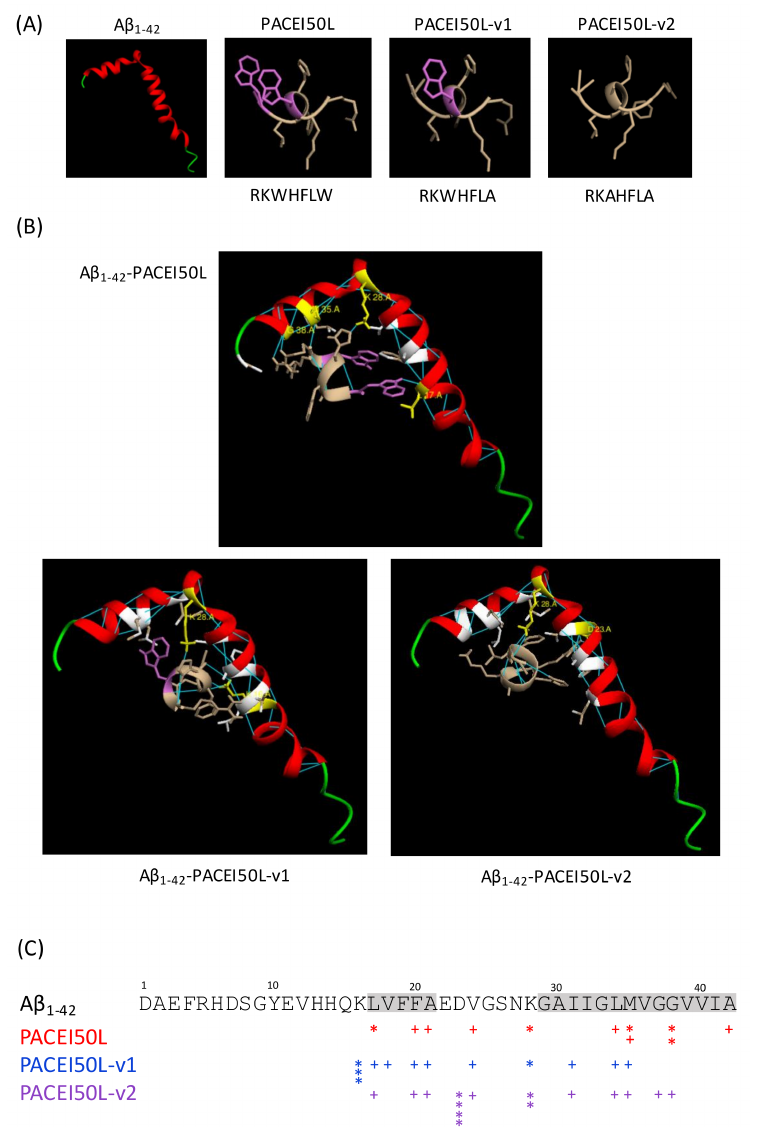
Figure 5. The molecular docking model of the A β 1–42 monomer binding to PACEI50L, PACEI50L-v1, and PACEI50L-v2. ( A ) The structure of A β 1–42 (PDB, ID:1IYT), PACEI50L, PACEI50L-v1, and PACEI50L-v2; W residues are in purple. ( B ) PACEI50L is bound to A β 1–42 via five intermolecular H-bonds with L17, K28, M35, and G38. PACEI50L-v1 is bound to A β 1–42 via four H-bonds with K16 and K28. PACEI50L-v2 is bound via six intermolecular H-bonds with D23 and K28; A β 1–42 residues participating in molecular interactions are in yellow (H bonds) and white (hydrophobic interactions); H-bonds are in blue. ( C ) A schematic representation of molecular interactions between A β 1–42 and PACEI50L (red), PACEI50L-v1 (blue), and PACEI50L-v2 (purple); * intermolecular H-bond, + hydrophobic interaction, hydrophobic domains in A β 1–42 are highlighted in